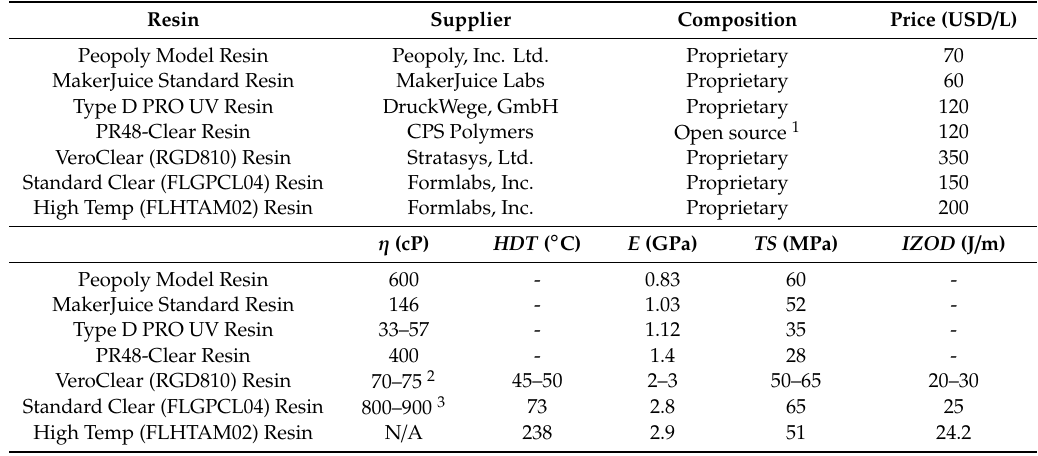
Table A1. Commercial SLA resin systems and their properties.